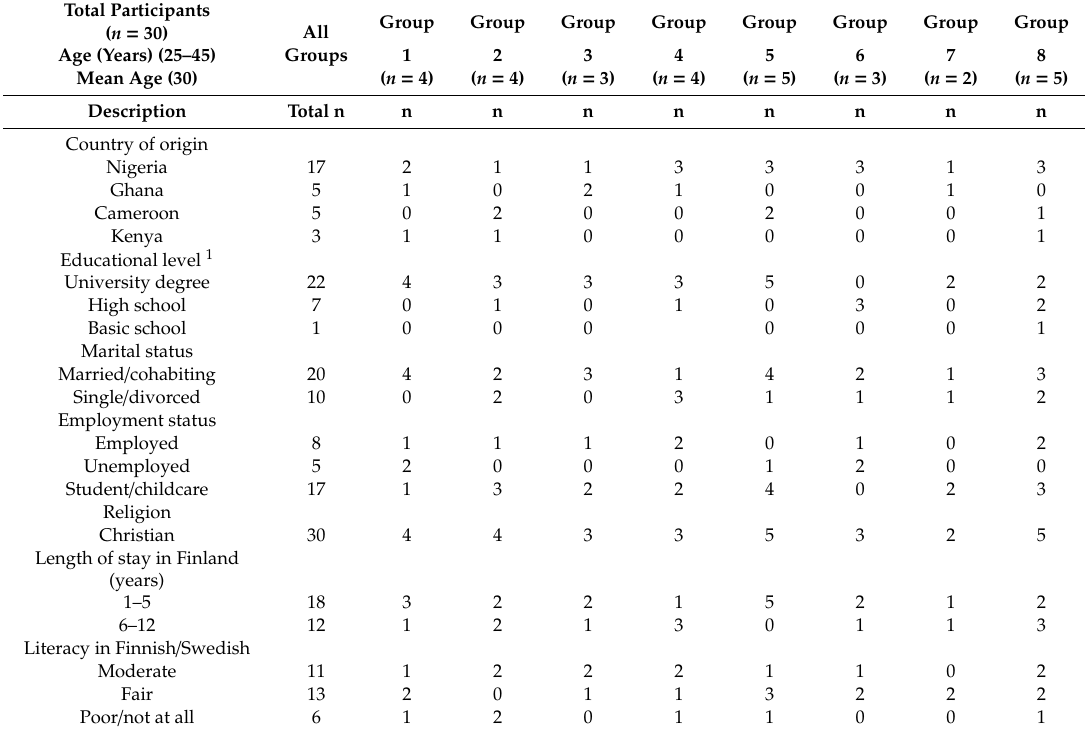
Table 1. Characteristics of study